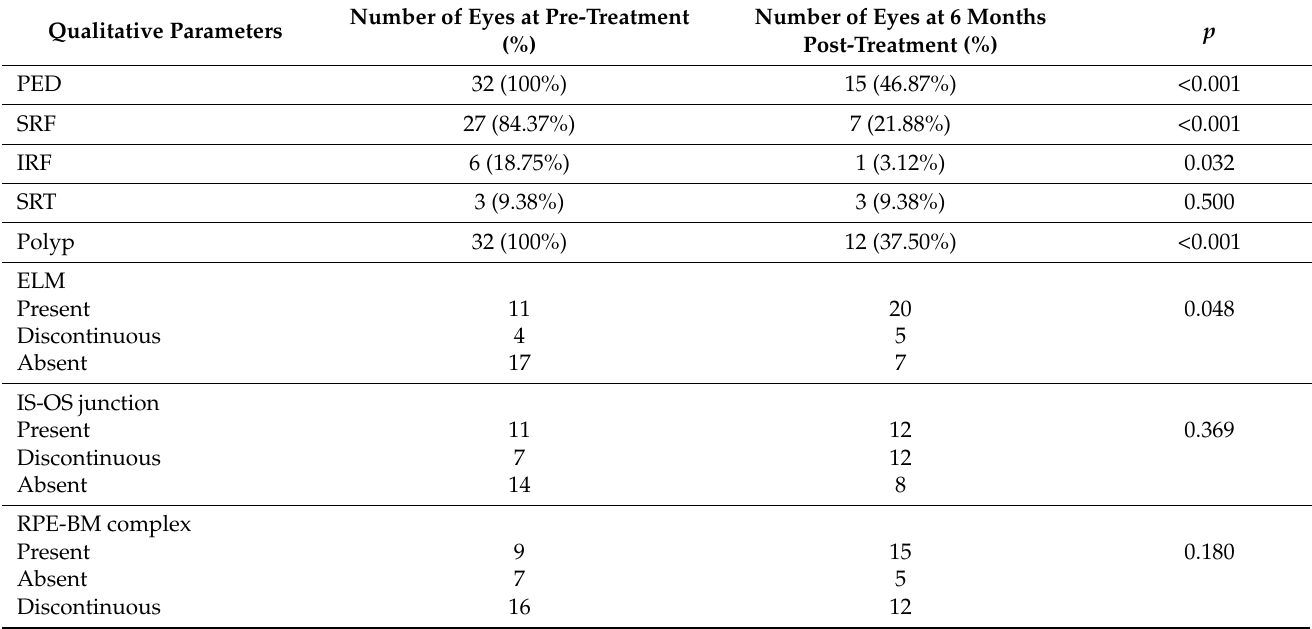
PED: pigment epithelium detachment. SRF: sub-retinal fluid. IRF: intraretinal fluid. SRT: sub-retinal tissue. ELM: external limiting membrane. IS-OS junction: inner segment and outer segment of photoreceptor junction. RPE-BM complex: retinal pigment epithelium- Bruch’s membrane complex. p : p -values are statistically significant ( p <